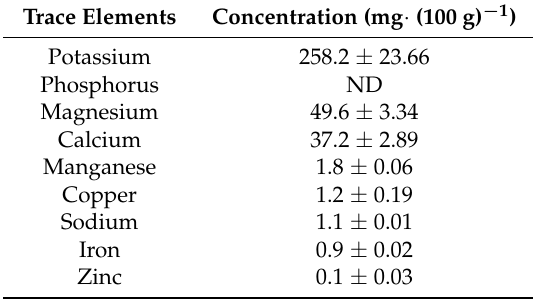
Table 2. Trace elements in spent coffee